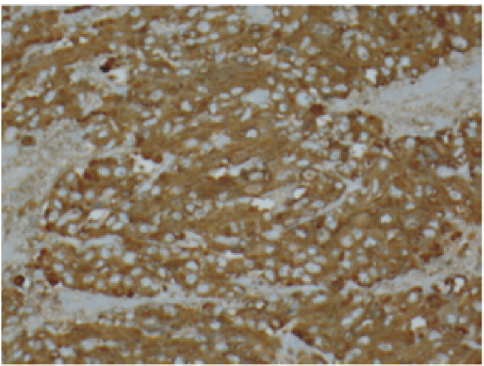
Figure 4: HC 40x chromogranin.